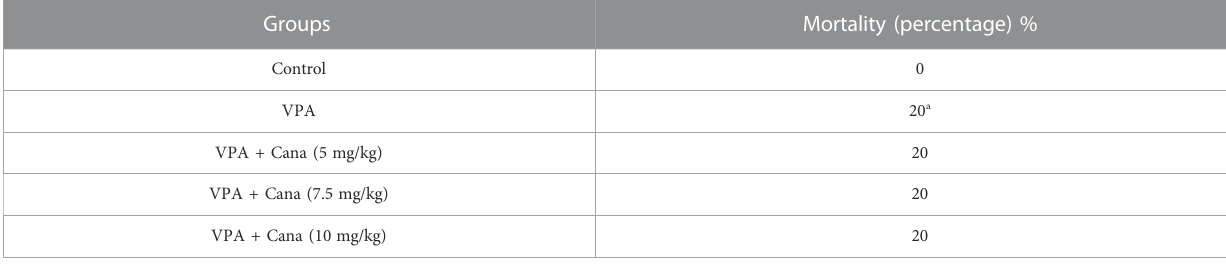
TABLE 2 Effect of canagli fl ozin (5 mg/kg, 7.5 mg/kg, and 10 mg/kg) on mortality percentage.